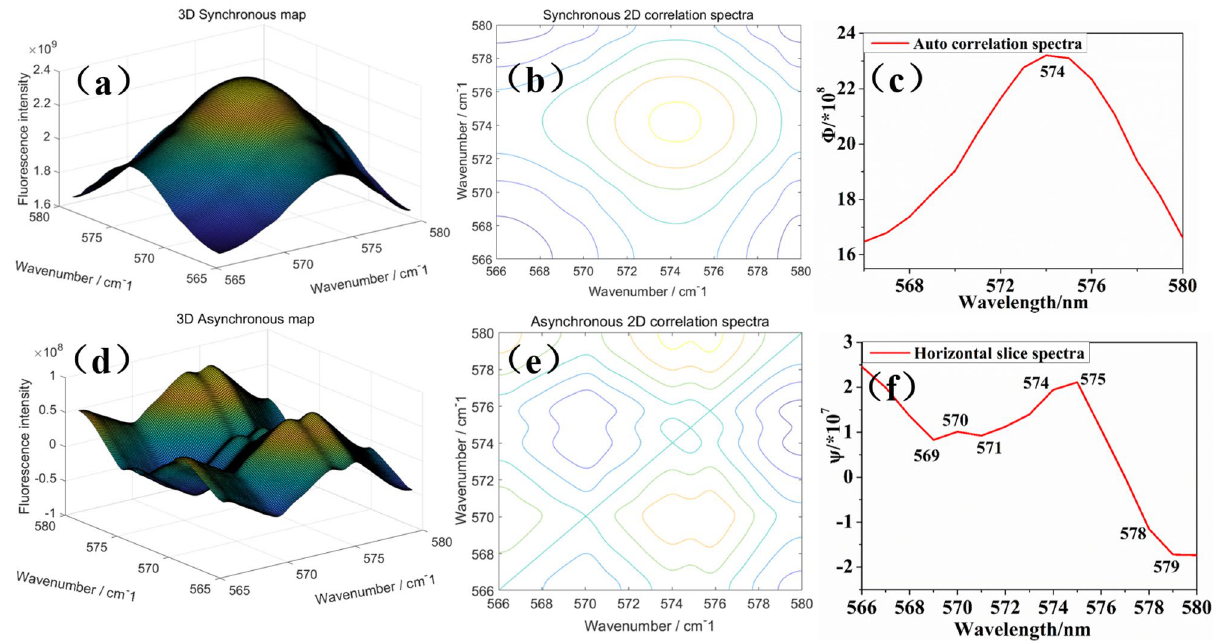
Figure 6. Two-dimensional correlation spectrum of CNF-3 at different pH. ( a ) 3D synchronous map. ( b ) Synchronous 2D correlation spectra. ( c ) Auto correlation spectra. ( d ) 3D asynchronous map. ( e ) Asynchronous 2D correlation spectra. ( f ) Horizontal slice